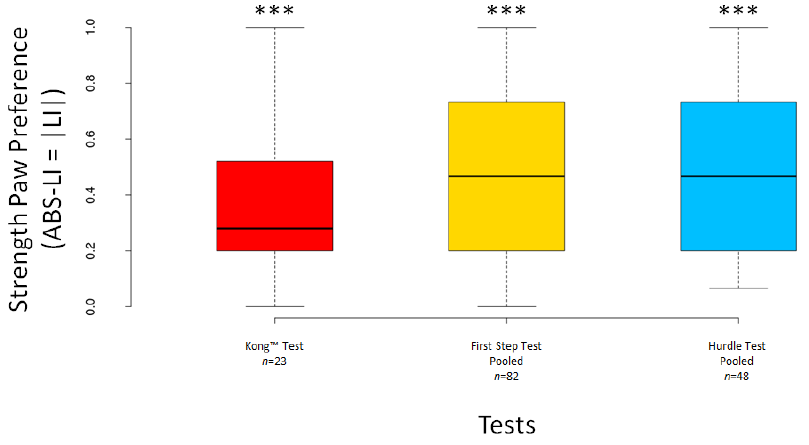
Figure 8. Boxplots showing dogs’ ABS–LI scores for the Kong™, the pooled First Step and the pooled Hurdle Test. Asterisks indicate significant deviations from 0 (*** p < 0.001). Table 2. Correlations of LI and ABS–LI scores between the different tests (i.e., Kong™ Test, pooled First Step and pooled Hurdle Test). Sample sizes ( N ), Spearman’s correlation coefficients (r s ), and Bonferroni-corrected p-values are shown (* p < 0.05).